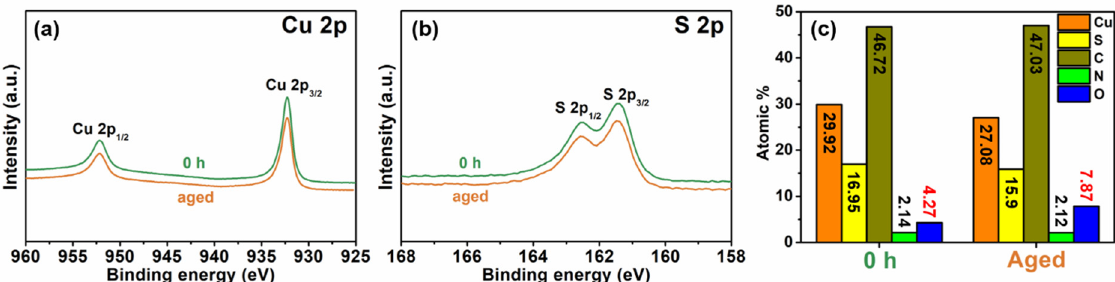
Figure 4. XPS spectra of the samples fabricated from the non-aged and aged NPs in ( a ) the Cu 2p region and ( b ) the S 2p region. A bar chart ( c ) showing the elemental compositions (at. %) of the samples fabricated from the non-aged and aged NPs is also provided.